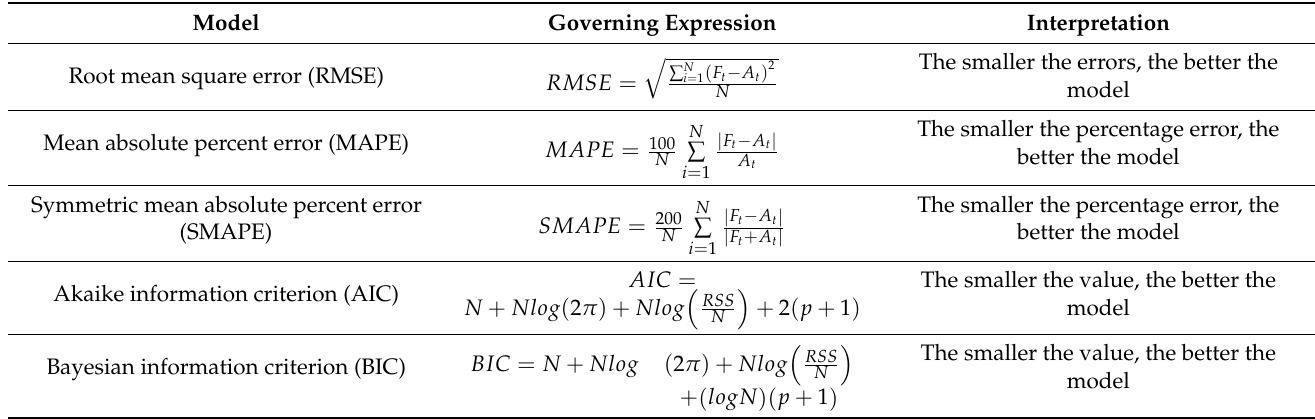
Table 7. Governing expression of each statistical model and its interpretations.